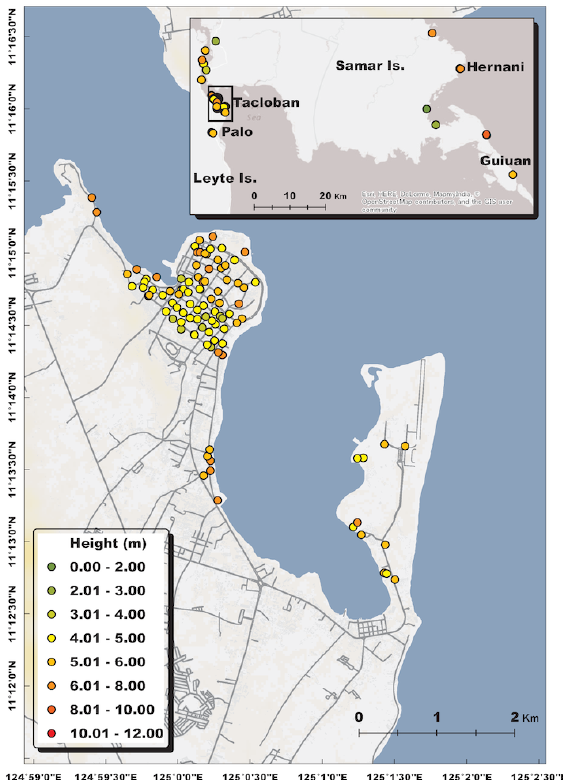
Figure 7. Storm surge inundation (Leyte Island and western Samar Island) and surface wave heights (eastern Samar Island) with respect to the local mean sea